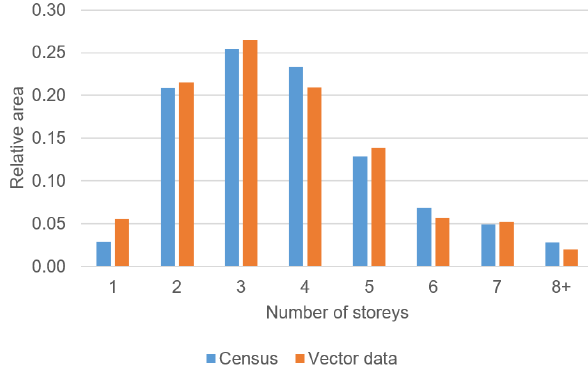
Figure 5. Comparison of relative building footprint areas of each height class between census and vector data